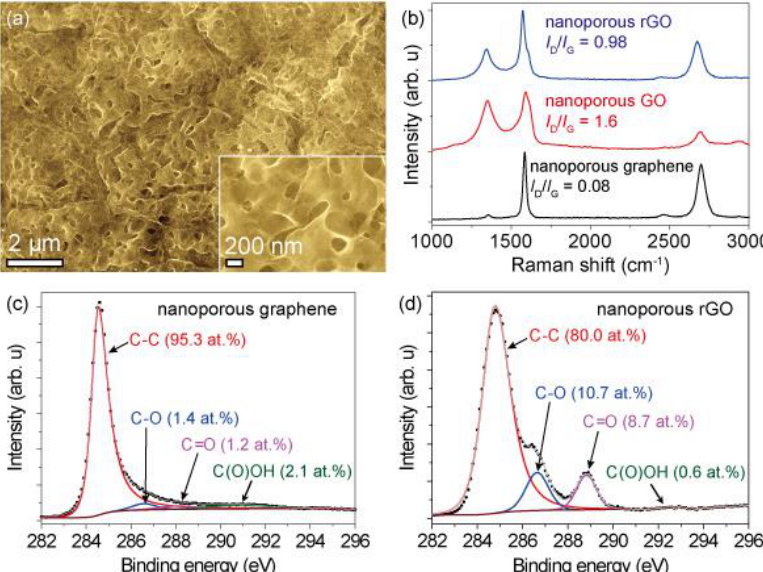
Figure 2. Characterizations of nanoporous rGO. ( a ) SEM images of nanoporous rGO with an oxygen content of 20.0 at.%. ( b ) Raman spectra of pristine nanoporous graphene, nanoporous GO, and nanoporous rGO. X-ray photoelectron spectra of C 1s for ( c ) pristine nanoporous graphene and ( d ) nanoporous rGO with an oxygen content of 20.0 at.%.